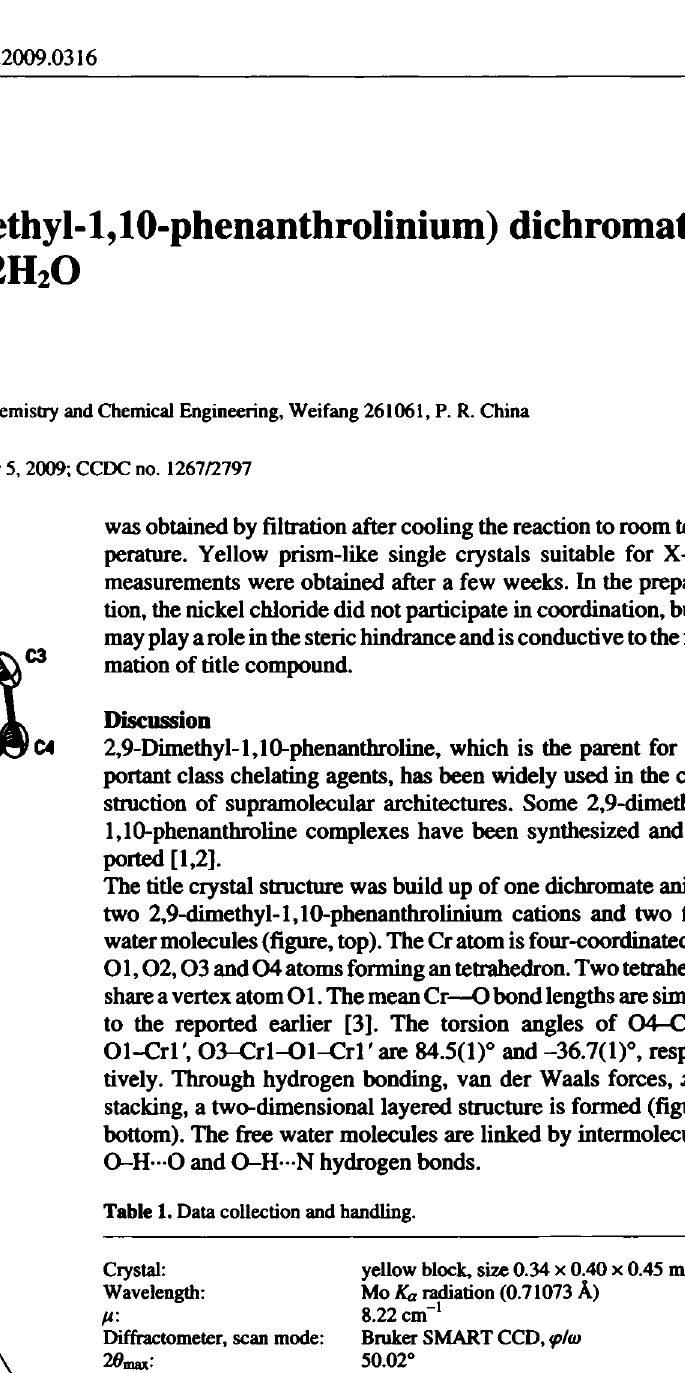
Table 2. Atomic coordinates and displacement parameters (in Â 2